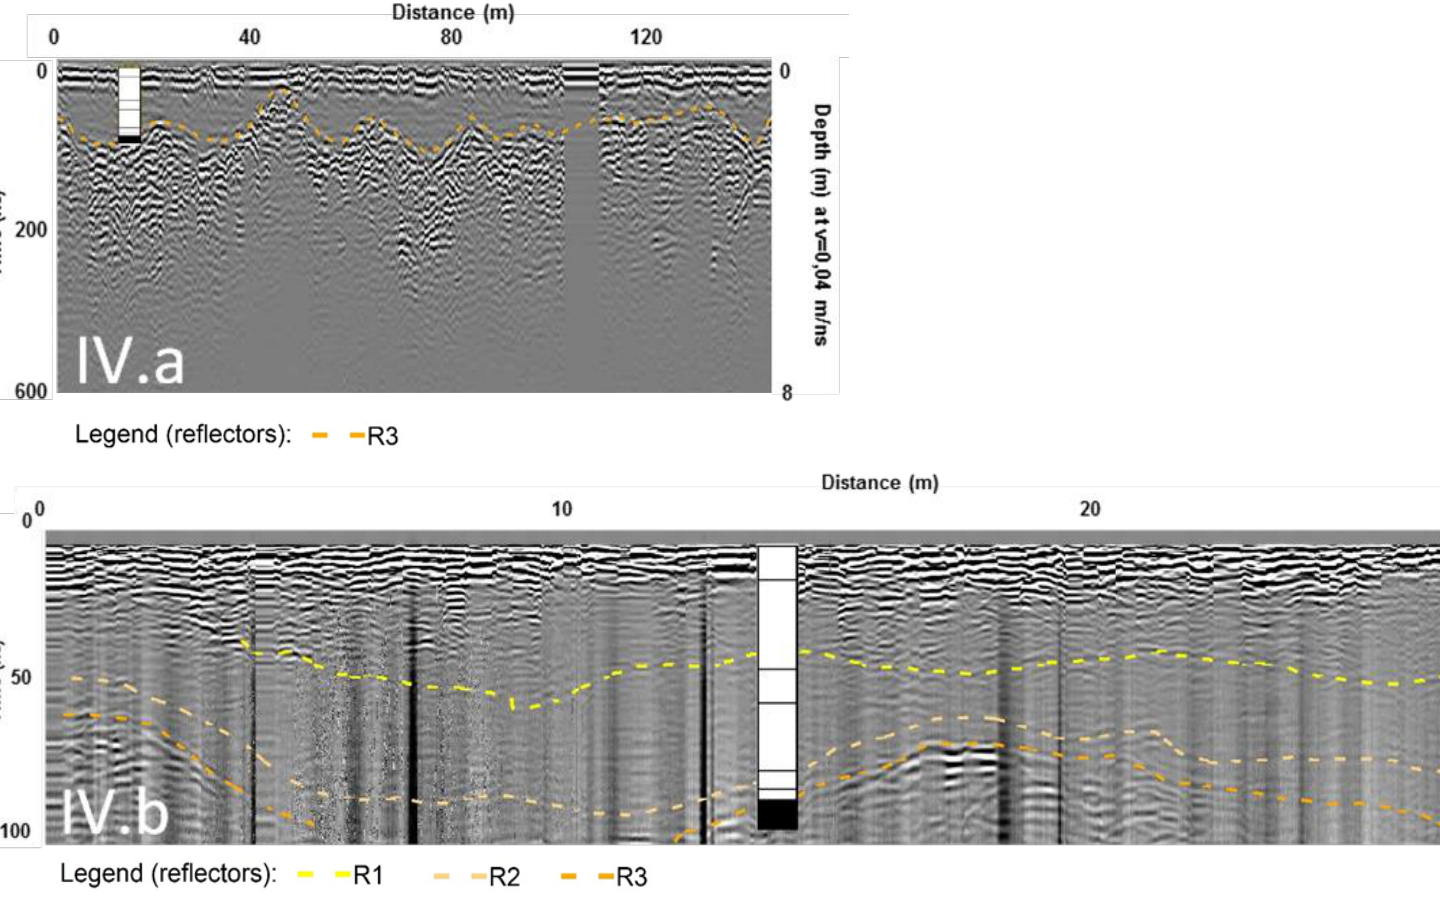
Figure 10. Peat Bog IV: example radargrams produced using the 100 MHz antenna (above) and the 500 MHz antenna (below). The transect selected includes the open core (see Figure 4 for more information). The dashed lines indicate interpreted reflections in the GPR signal (the R2 reflector was derived by interpretation of the results of the depth cores and GPR reflections for only parts of the